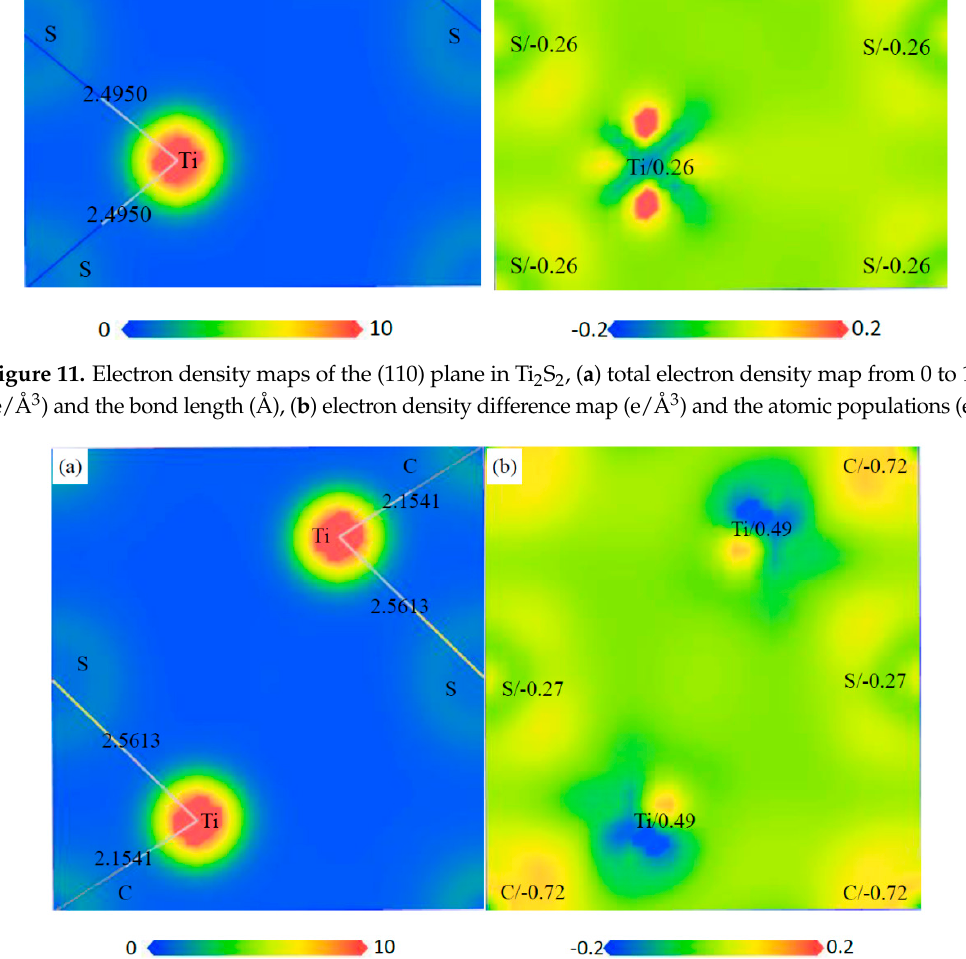
Figure 12. Electron density maps of the (1 1 0) plane in Ti 2 SC, ( a ) total electron density map from 0 to 10 (e/Å 3 ) and the bond length (Å), ( b ) electron density difference map (e/Å 3 ) and the atomic populations (e).